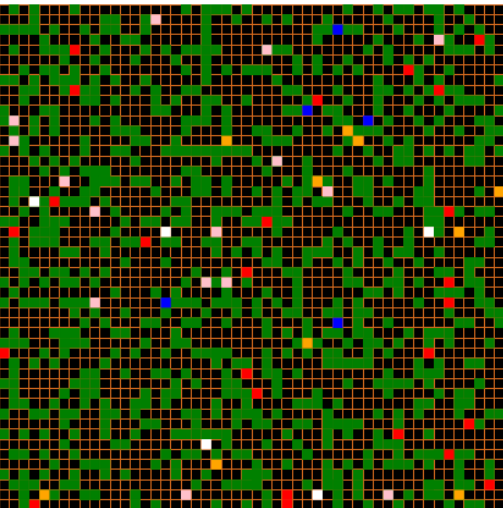
50 grid environment for the discrete agent-based Figure 4. Random distribution of agents in a 50 × model. The colored dot represents individuals with their specific status (Susceptible: green; exposed: yellow; infected: red; asymptomatic: pink; recovered with treatment: blue; recovered without treatment: